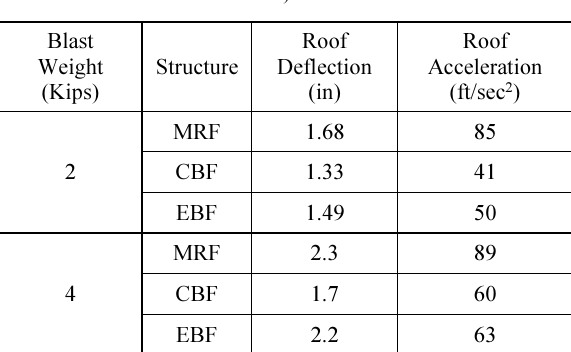
Table 7. Maximum roof deflection and acceleration for MRF,